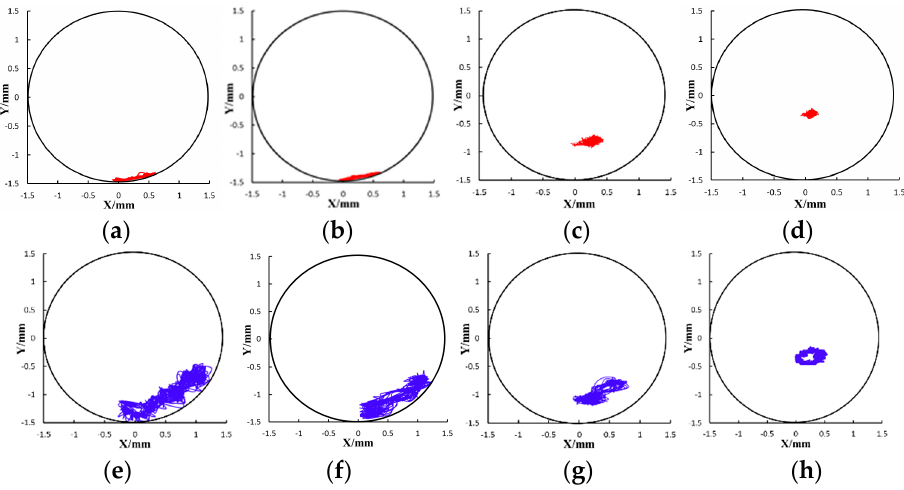
Figure 7. Trajectory curve of BHA center under different positions: ( a–d ) are the numerical simulation